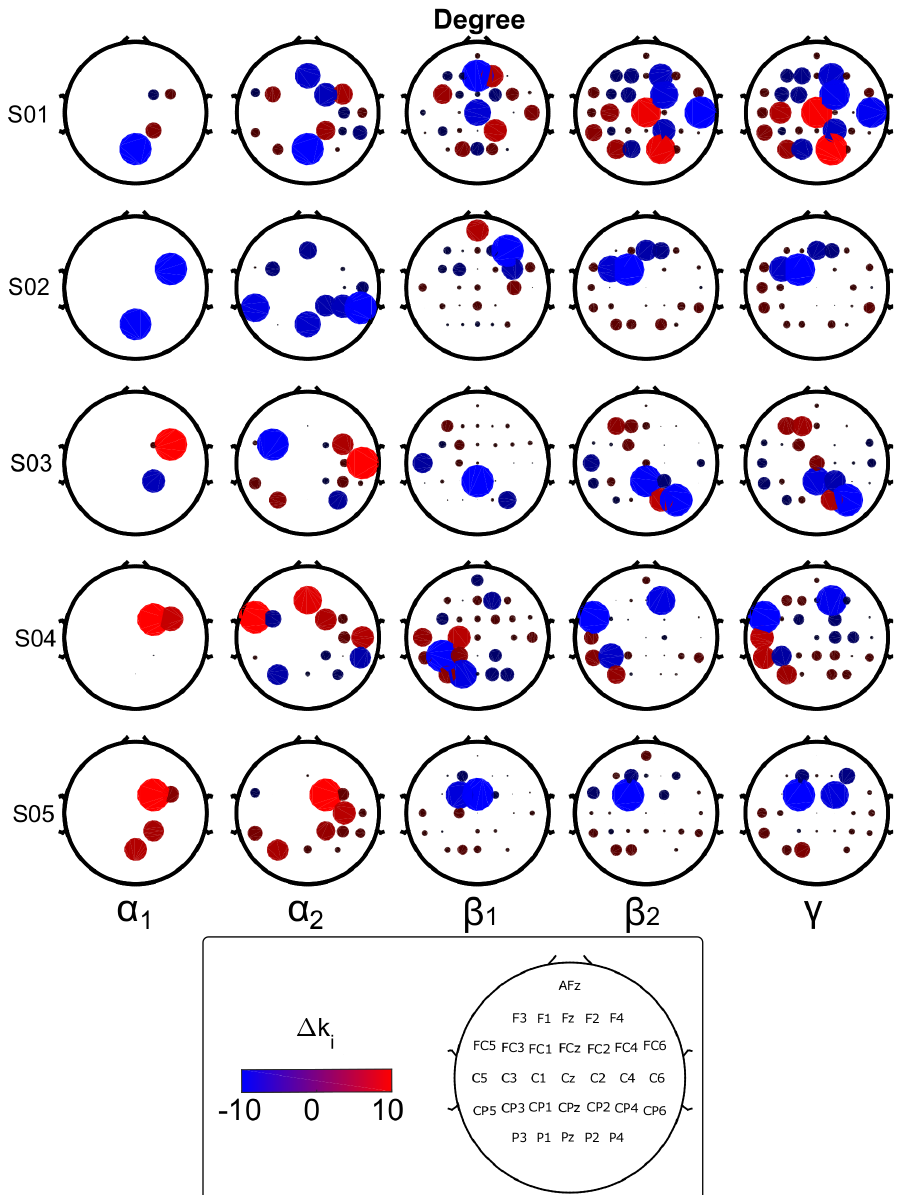
Figure 5. Degree variations between pre- and post-intervention for all subjects and frequency bands; r = 0.75 and ρ = 0.30. Plotted radii are subject-specific. Only statistically significant variations are shown ( p < 0.00002; Wilcoxon